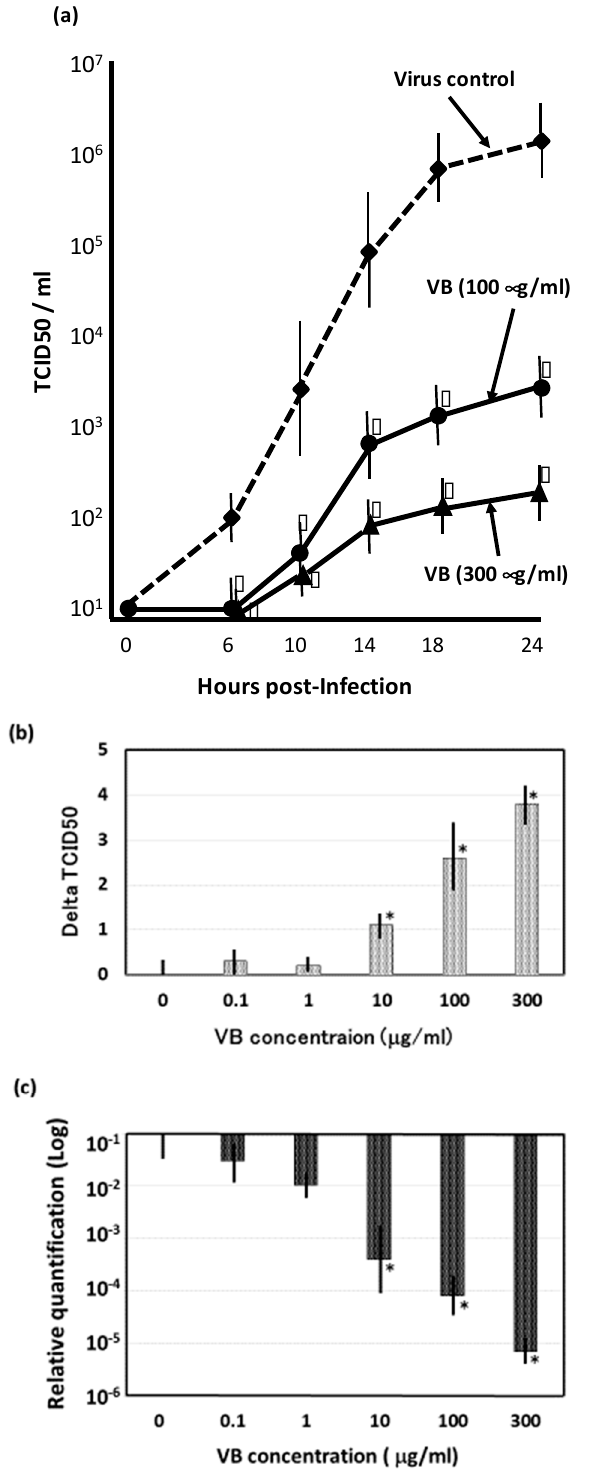
Figure 1. Inhibitory effects of virus block (VB) on the one-step growth of influenza virus. ( a ) Serial changes in viral load in culture medium. ( b ) Concentration-dependent response to the viral load at 24 h; TCID 50 assay. ( c ) Concentration-dependent response to the viral load at 24 h; relative quantitative RT–PCR. * p < 0.001 relative to the virus control.